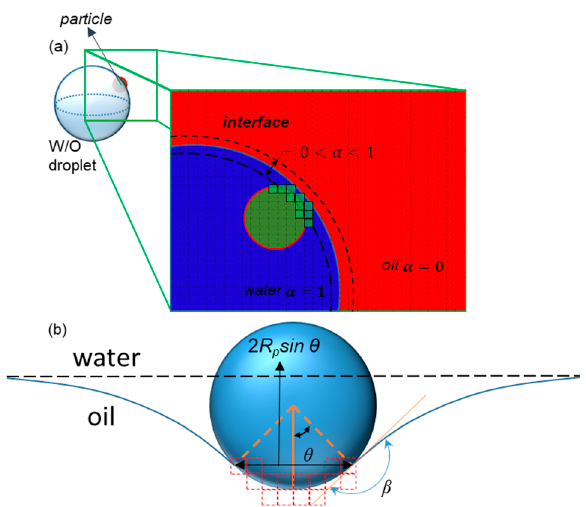
Figure 4. The interaction between a particle and an interface. ( a ) Green cells are those with volume fractions between 0 and 1 that are touched by the particle, or those for which the distance between their center and the center of the particle is less than the particle radius. The total volume of these cells equals NV σ . ( b ) The dimensions and parameters used to calculate the surface tension force exerted on the particle by the interface. The dashed red lines show the faces of touched cells.